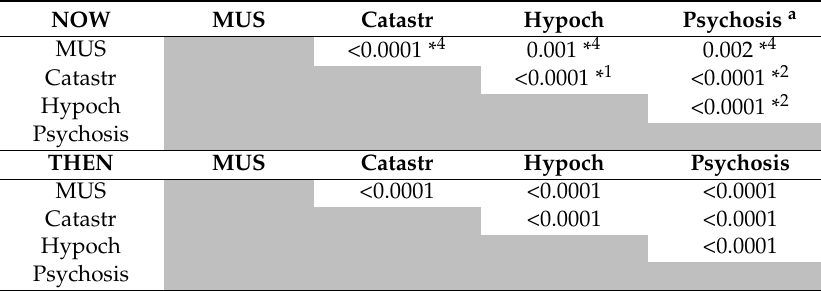
Table A10. Somatisation (MUS), catastrophising, hypochondria and psychosis.